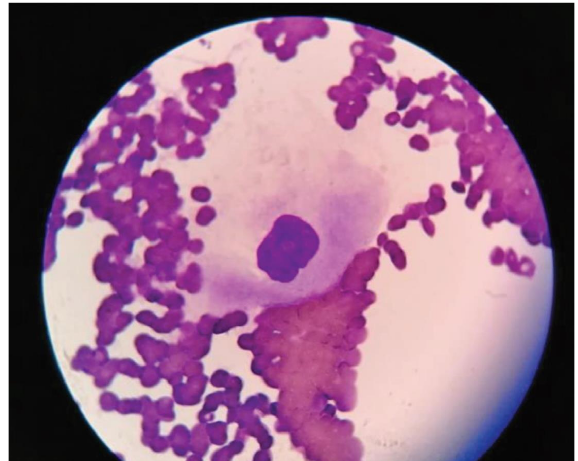
Figure 2: Brucella , Gram-negative